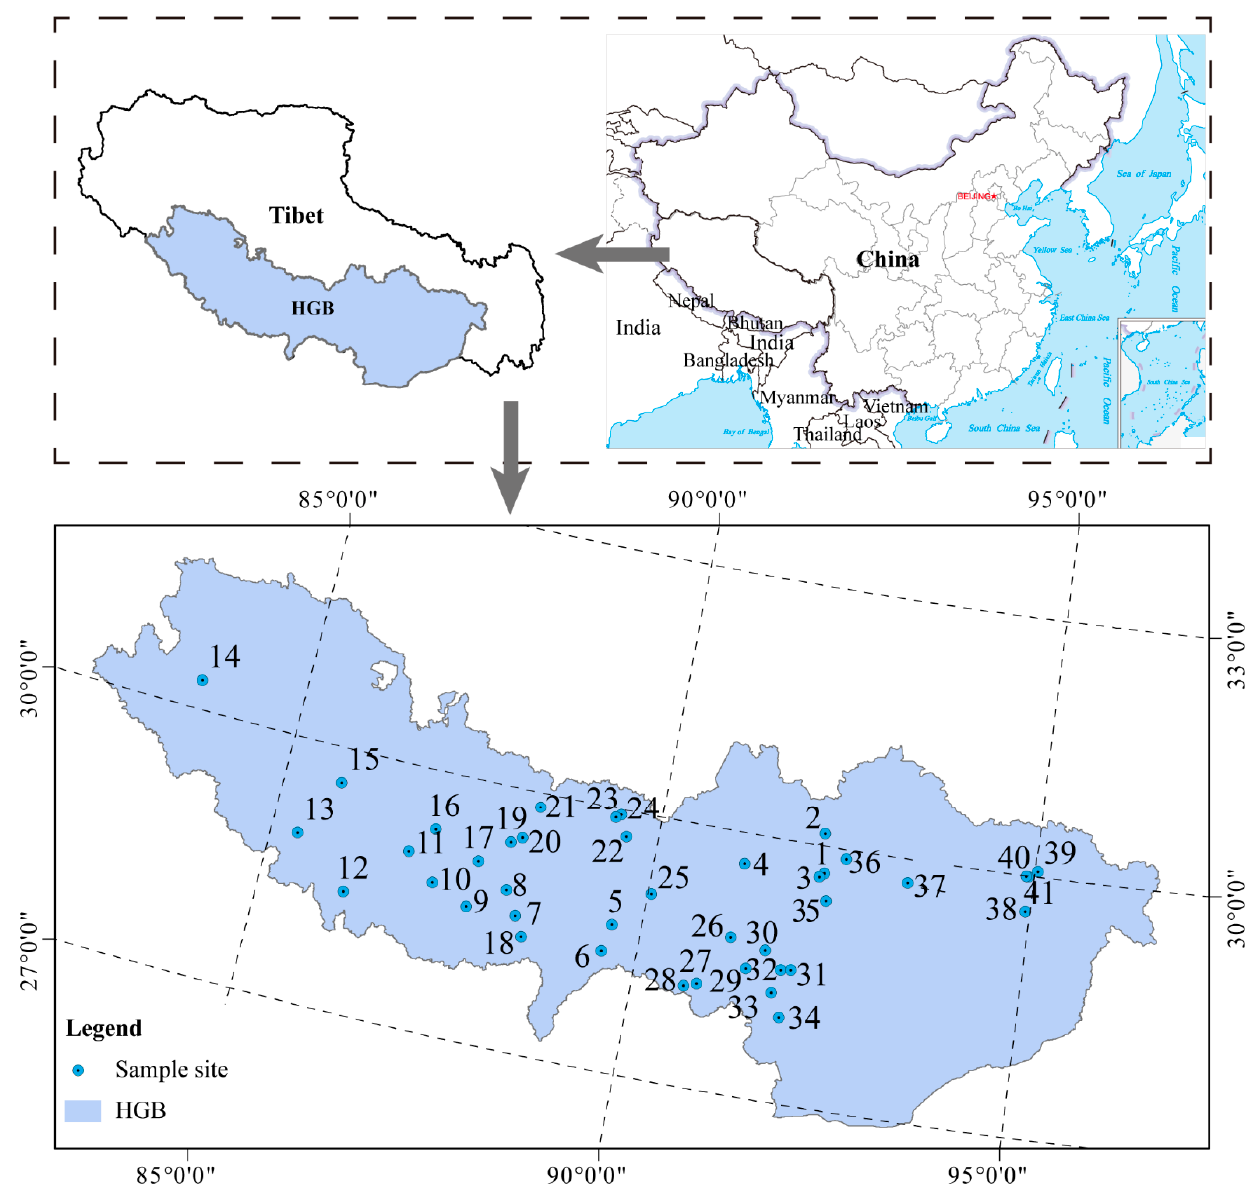
Figure 1. Distribution of the 41 surface sediment sampling sites in the HGB.